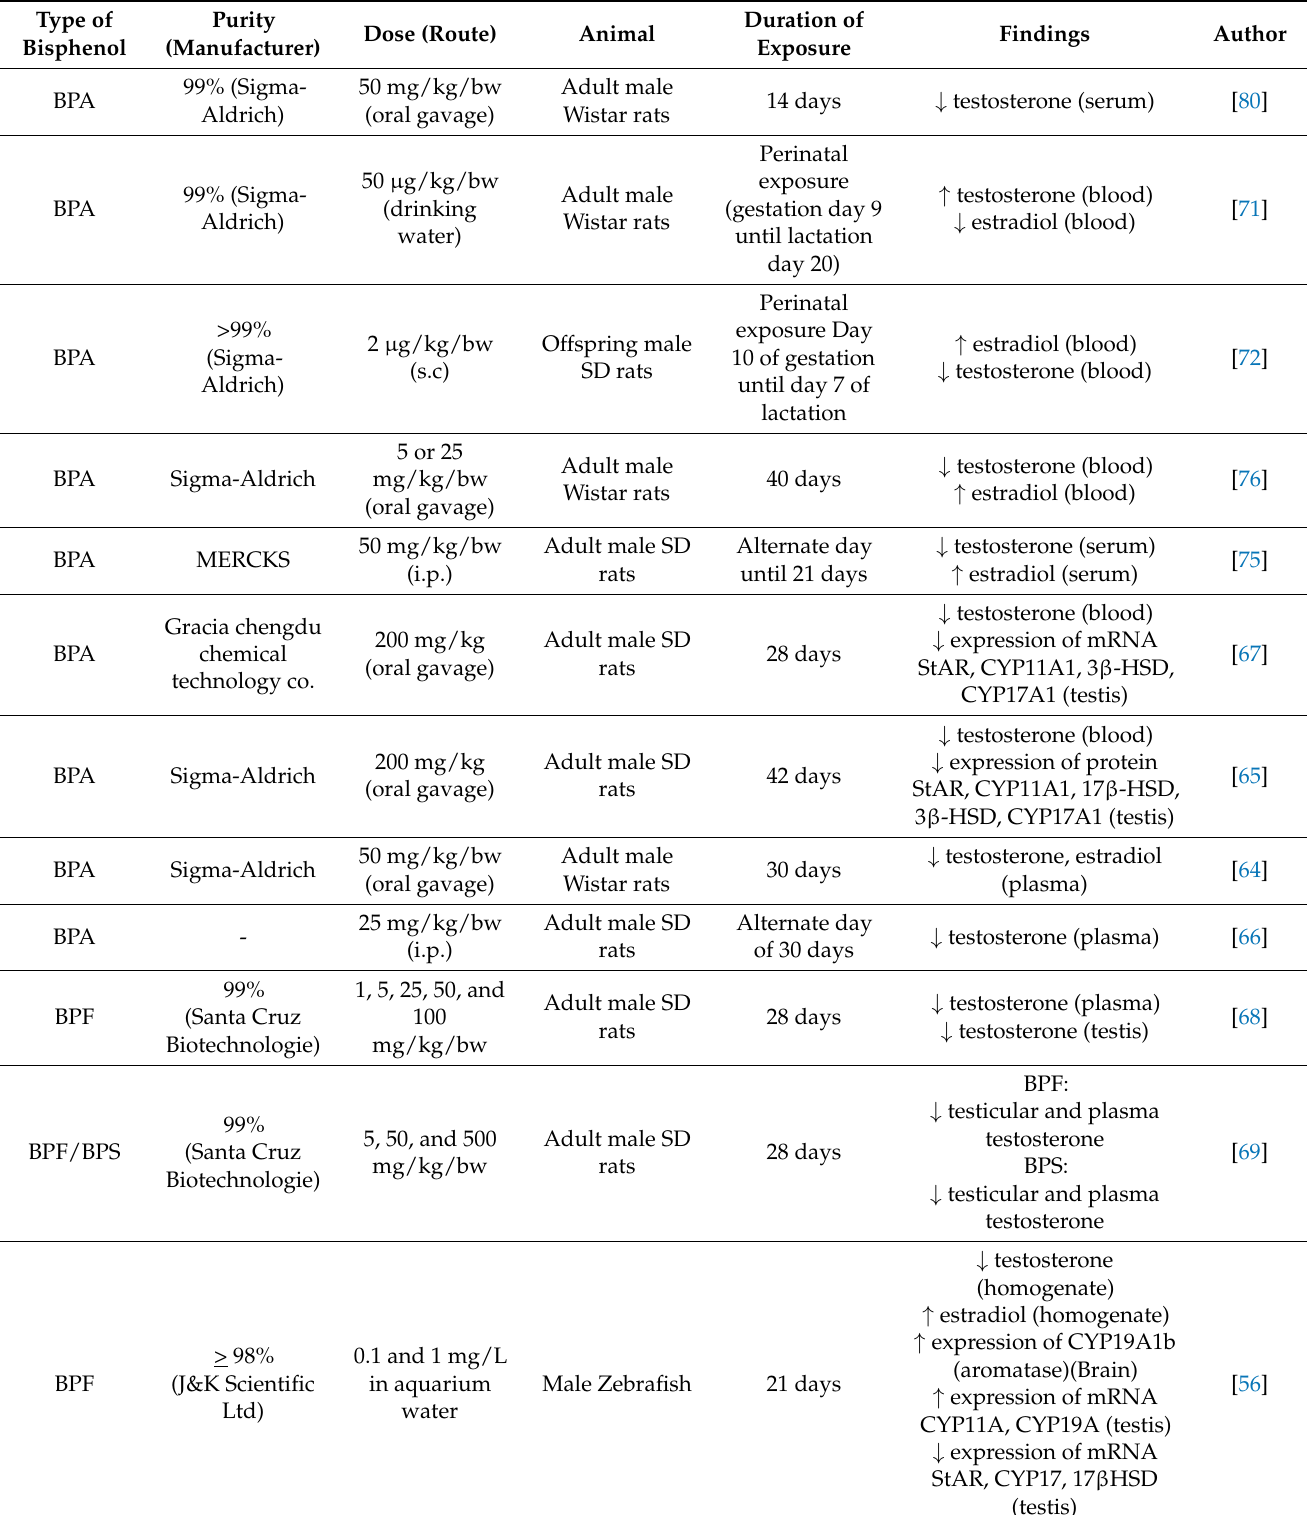
Table 2. The effects of BPA and its analogues on the steroidogenesis in male reproductive system. Type of